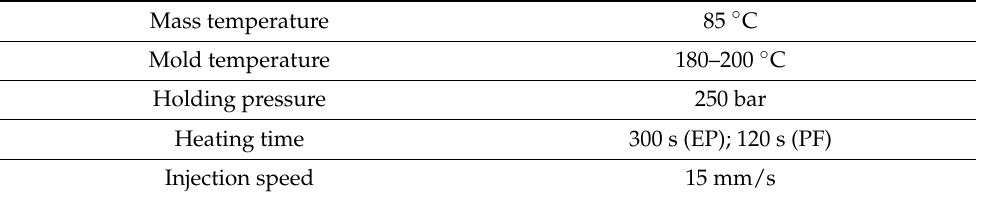
Table 3. Processing parameters of injection molding to fabricate test samples (EP 245/1 with 40 to 70 vol.-% hard magnetic